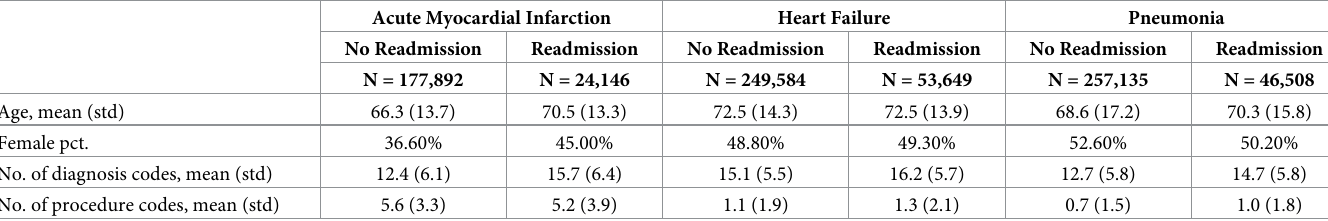
Table 1. Summary statistics of the predictors for each cohort assessed in this study population.